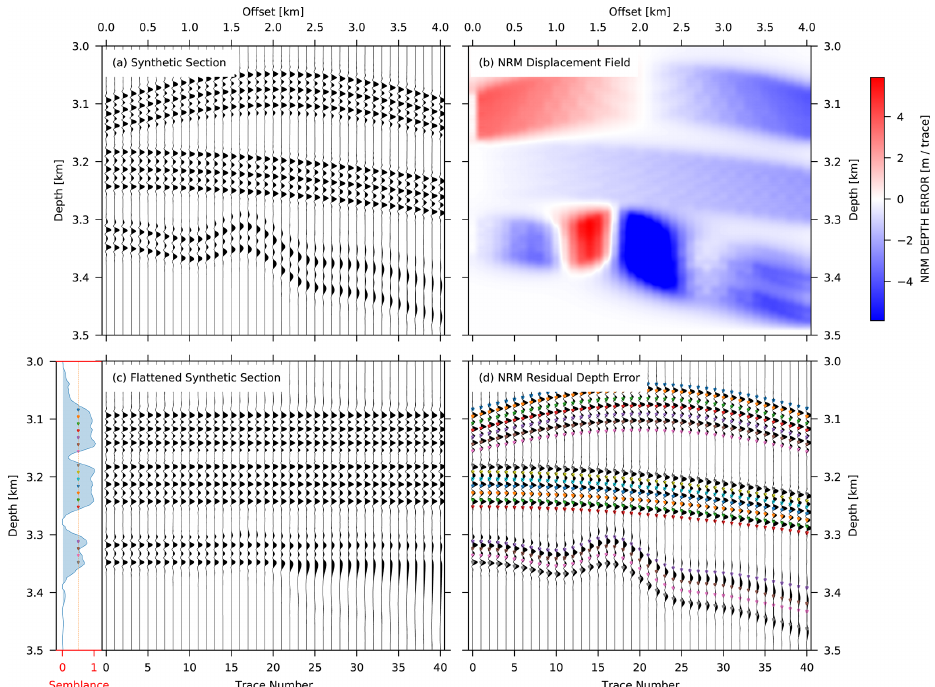
Figure 4. (a) Simulated geological situations with multiple sets of reflectors. (b) The NRM displacement of gather (a) calculated from trace n to the previous trace ( n − 1) for n > 1. (c) Application of the “relative-displacement correction” scheme from (b) to the gather of (a)